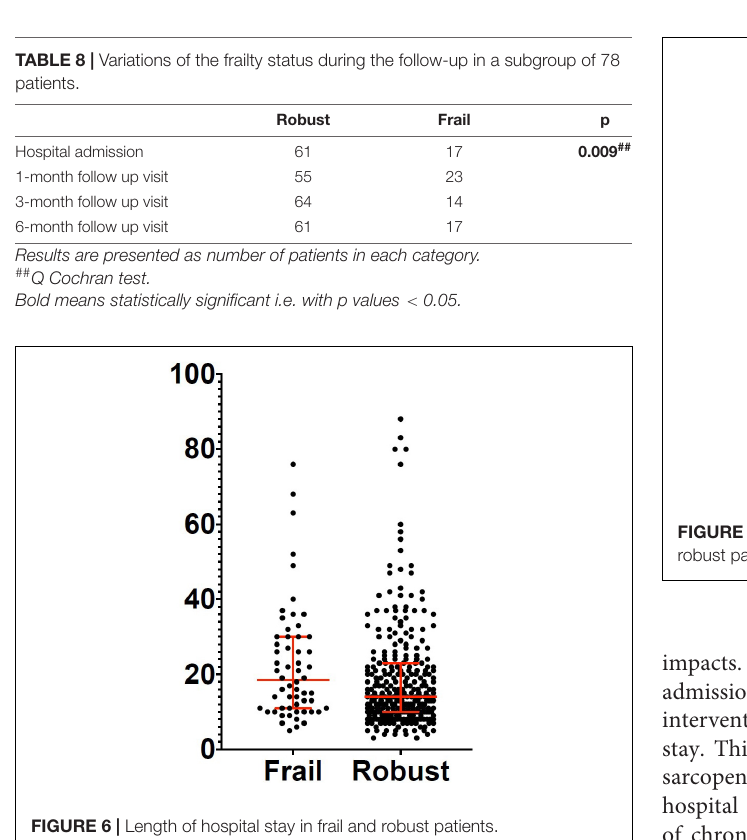
FIGURE 6 | Length of hospital stay in frail and robust patients.